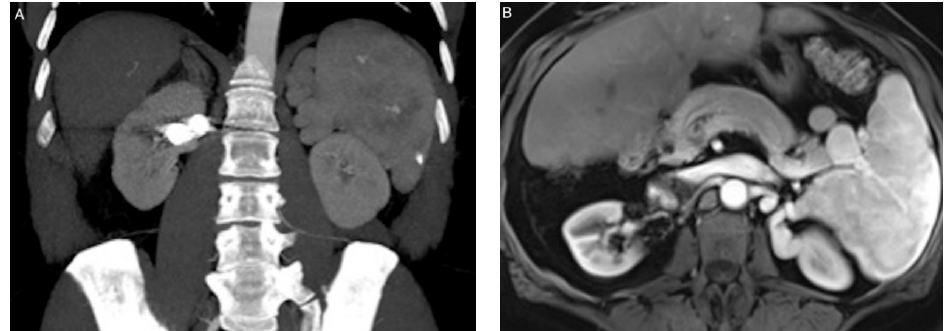
Figure 4. Follow-up computed tomography angiography at 1 month ( A ) and magnetic resonance imaging at 36 months ( B ) showing complete exclusion of both aneurysms, whose sizes remain unchanged.